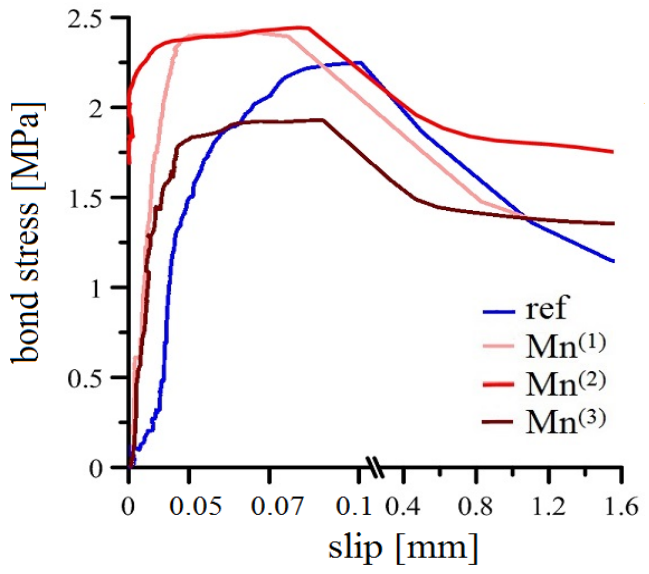
Figure 9. Results of modified bond strength tests (overview; curves—mean values).